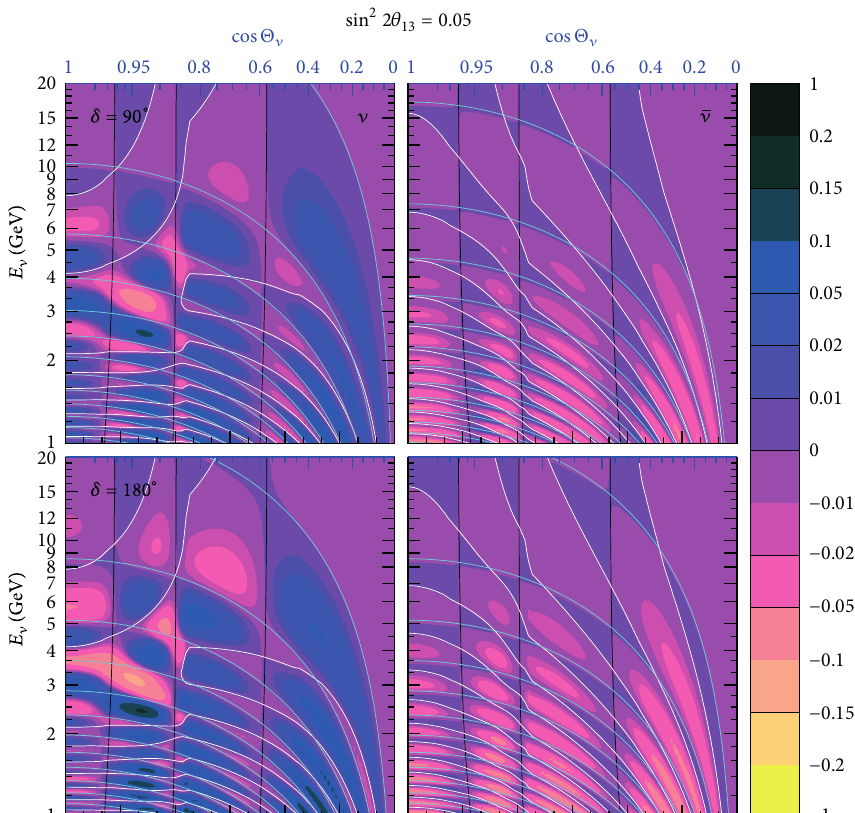
Figure 10: Oscillograms for the difference of probabilities Δ𝑃 CP 𝜇𝑒 (𝛿) = 𝑃 𝜇𝑒 (𝛿) − 𝑃 𝜇𝑒 (𝛿 0 ) with 𝛿 0 = 0 ∘ . Shown are the solar (black), atmospheric (white), and interference phase condition (cyan) curves from